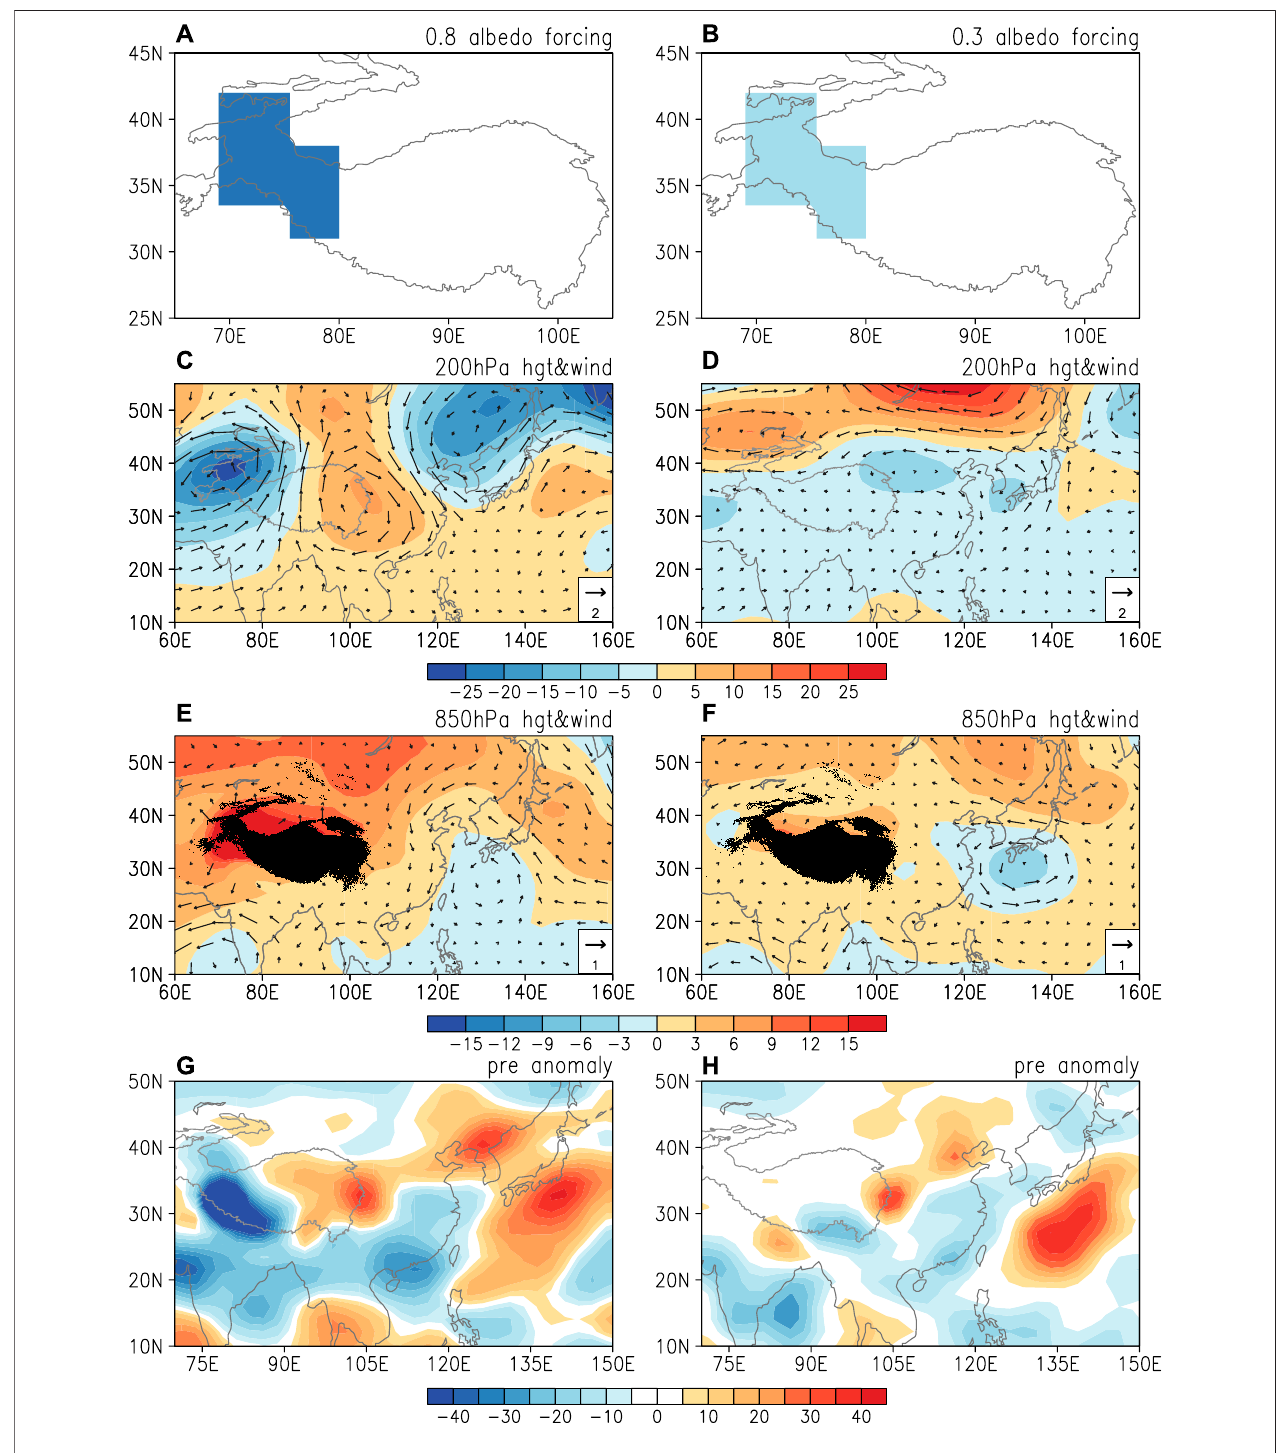
FIGURE 8 | Model (A) higher and (B) lower albedo forcing pattern. The model response of (C, D) 200hPa and (E, F) 850hPa geopotential height (hgt) (shading, gpm) andwind (vector, m/s)and (G, H) precipitation(pre) (mm/month) to (C,E,G) higher and (D,F,H) loweralbedoforcing.Thescaleforwinds in (C – F) isshownat the bottom-right corner.